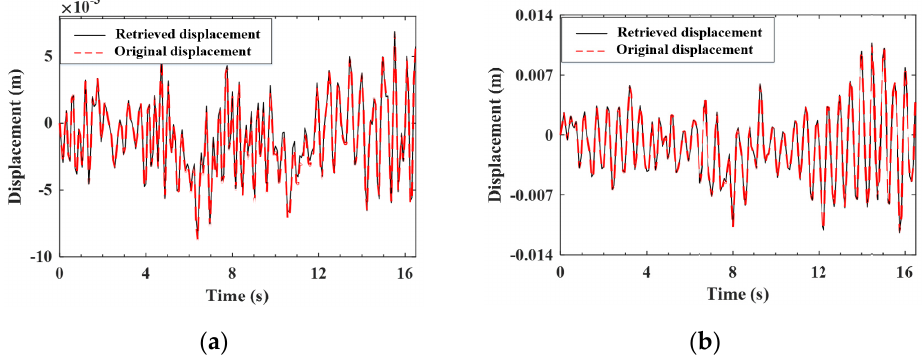
Figure 6. Retrieved and original displacement responses of the test vehicle (Class A roughness). ( a ) front axle; ( b ) rear axle.